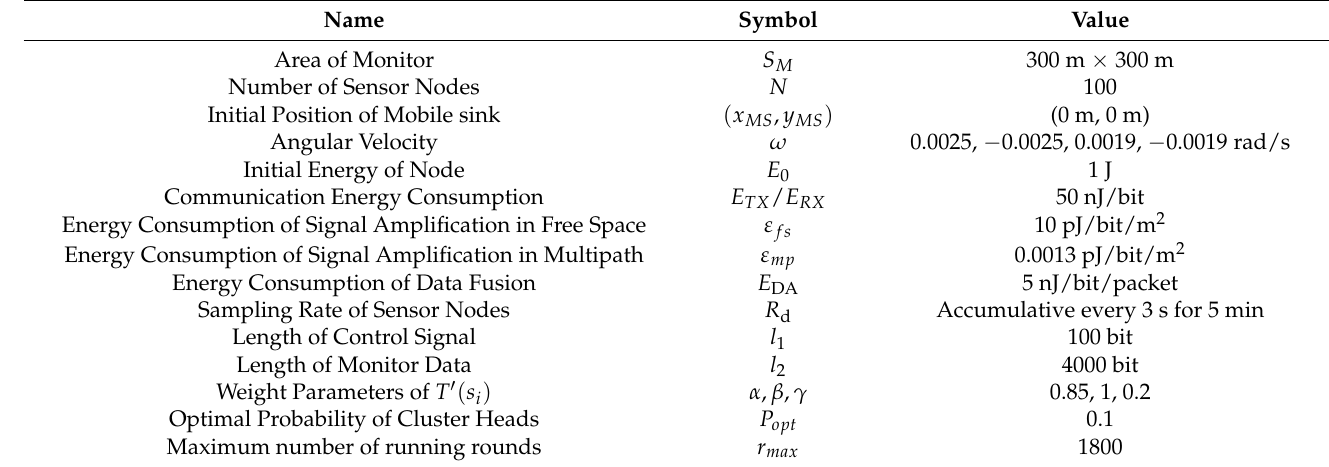
Figure 10. Moving trajectory of the mobile sink. Simulation parameters related to the experiment are shown in Table 2. Table 2. Experimental